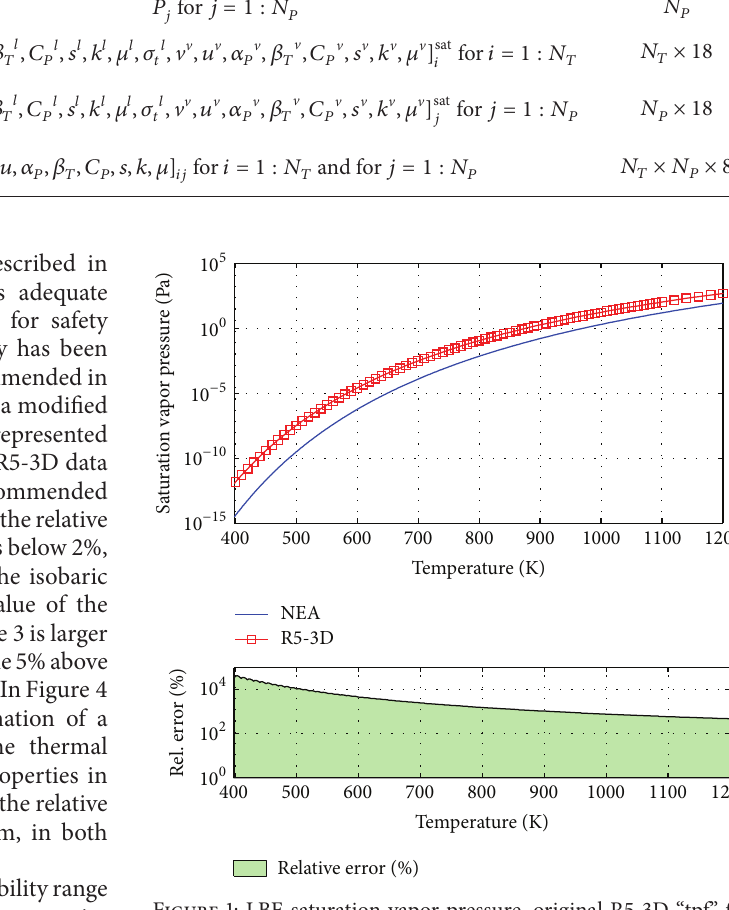
Figure 1: LBE saturation vapor pressure, original R5-3D “tpf” file versus NEA